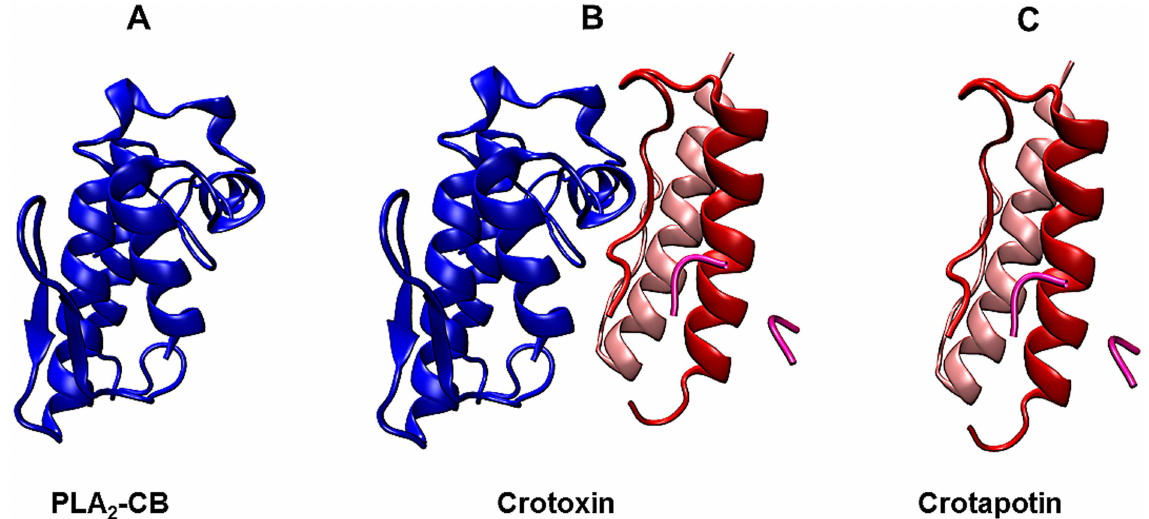
Fig 1. Crystal structure of the complex crotoxin from Crotalus durissus terrificus venom. The basic subunit(PLA 2 -CB) is displayedin blue (A). The overall structure of crotoxin complex(B). The three chains of acid subunit(crotapotin)is shown in red [ α ], light pink [ β ] and pink [ γ ] and (C) (PDB ID: